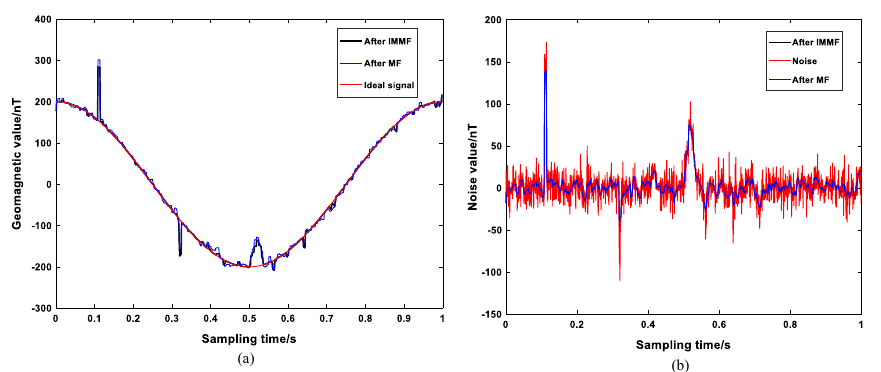
Fig. 4 The ideal signal and processed signal after IMMF and